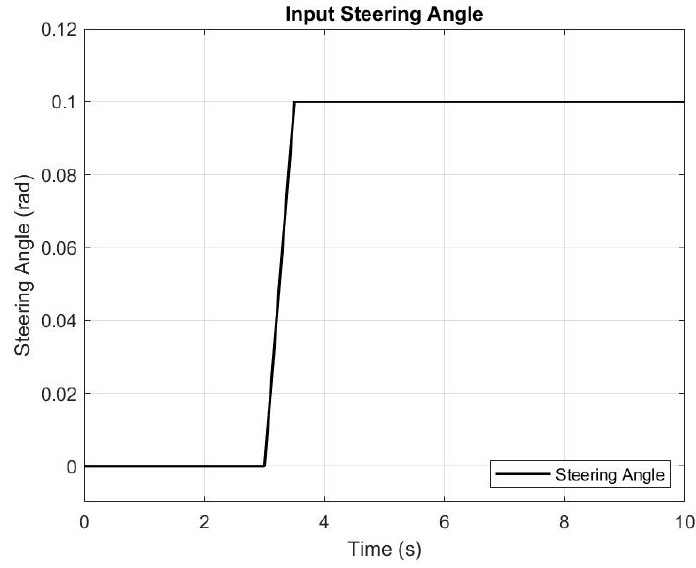
Figure 5. Ramp steering angle input for circular-path maneuver.